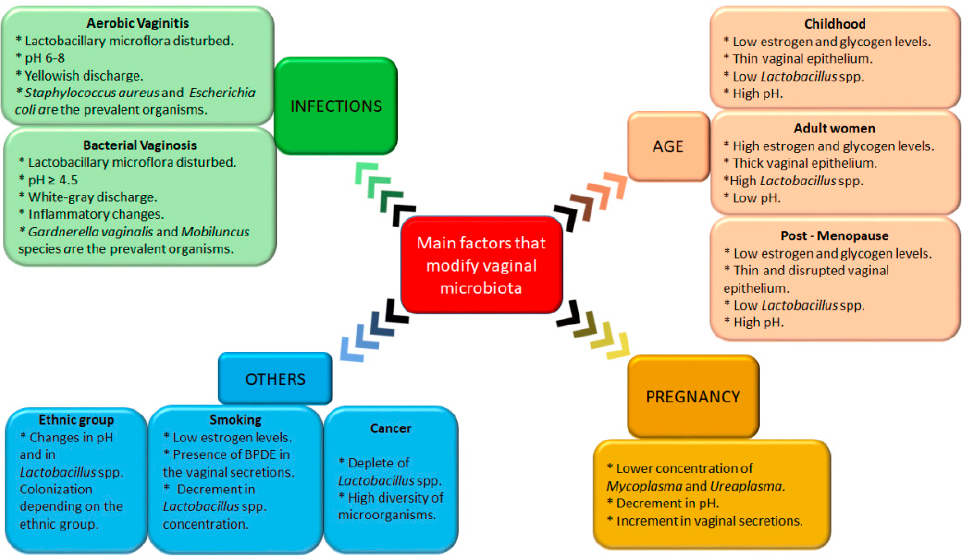
Figure 2. Main factors that modify vaginal microbiota. Different factors could change the composition of vaginal microbiota, triggering modifications in this area. Some of these factors include the woman’s age, pregnancy, ethnic race, presence of cancer, and smoking habit, among